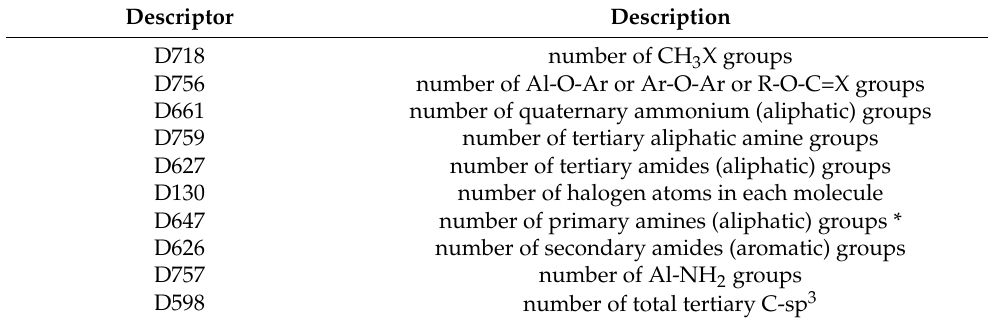
Table 3. Ten of these molecular descriptors as features that were closely associated with the 24 SAs.